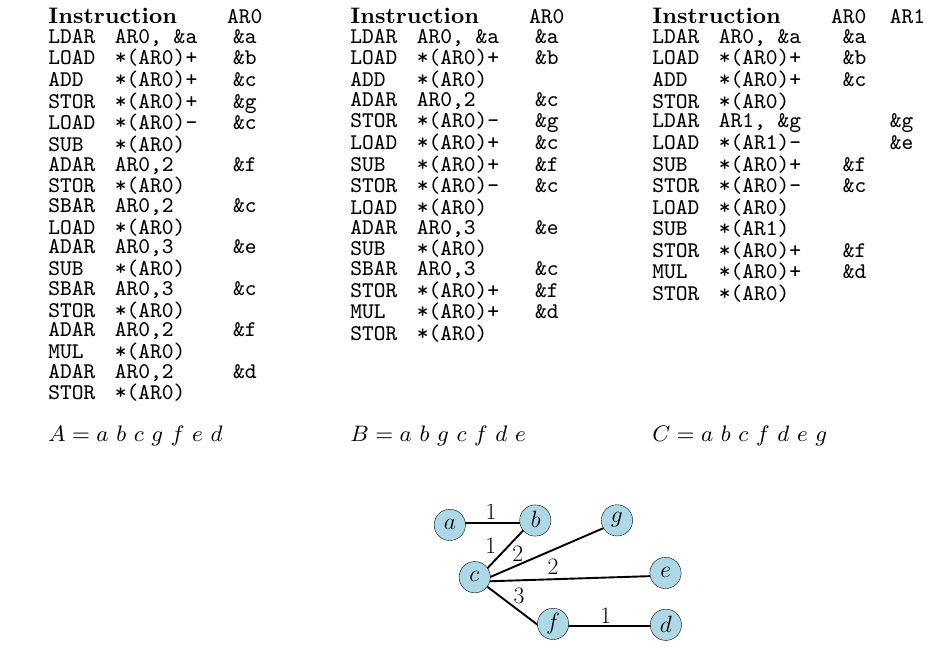
Table 1 Pseudo machine codes for the code fragment from Fig. 1 assuming different memory layouts A , B and C and either one ( A and B ) or two ( C ) available address registers.